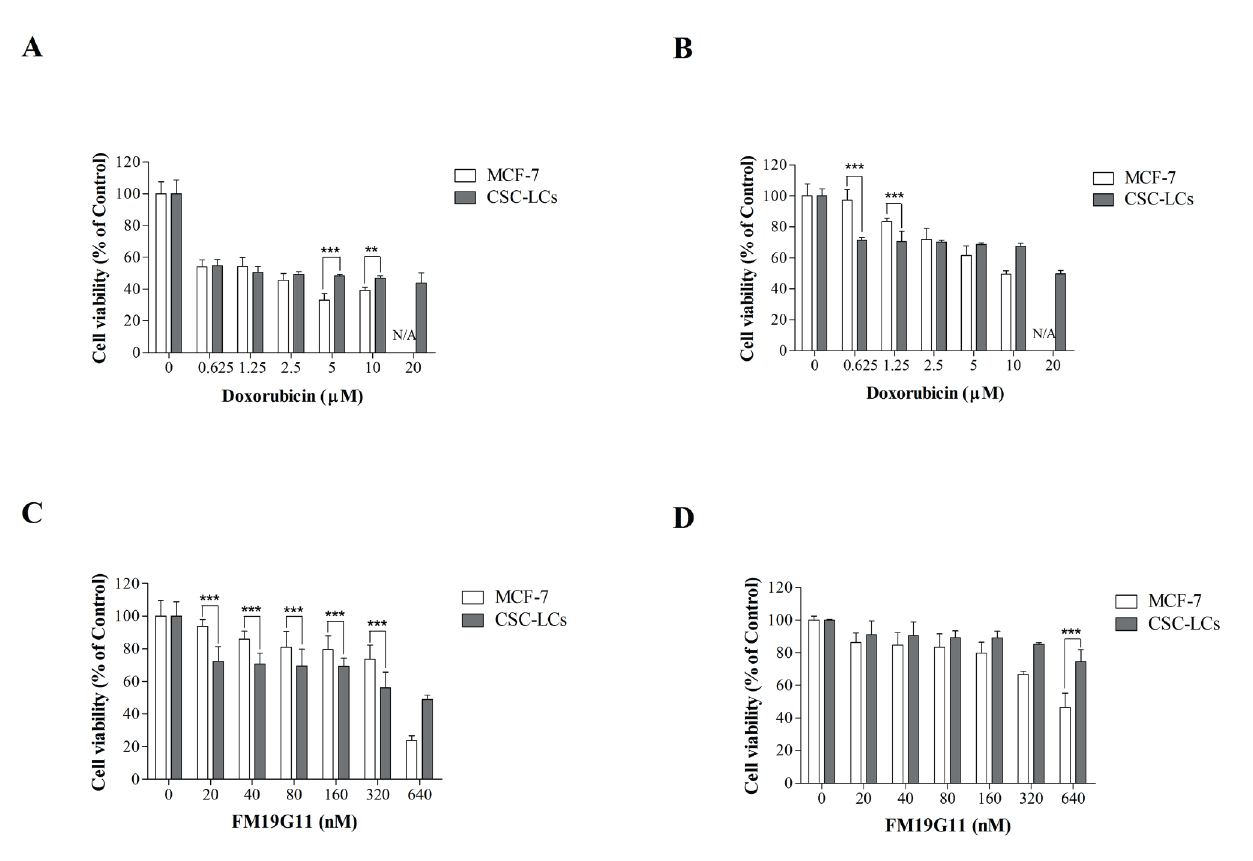
FIGURE 1 - Cytotoxic effect of doxorubicin and FM19G11 on MCF-7 and CSC-LCs in normoxic and hypoxic conditions. (A, C) Normoxia; (B, D) Hypoxia. * P < 0.05, ** P < 0.01, and *** P < 0.001 as compared to corresponding